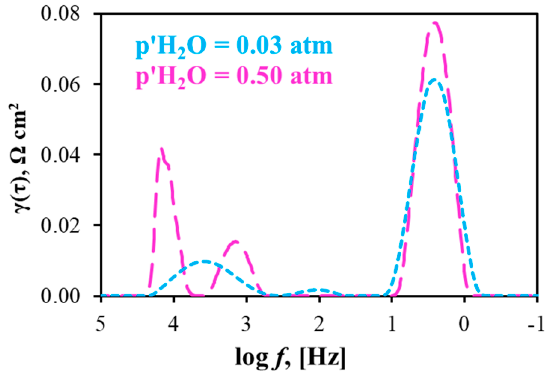
Figure A4. Contribution of partial resistances in the total resistance of the electrodes (R p ). These data were obtained from the DRT results (Figure A3).